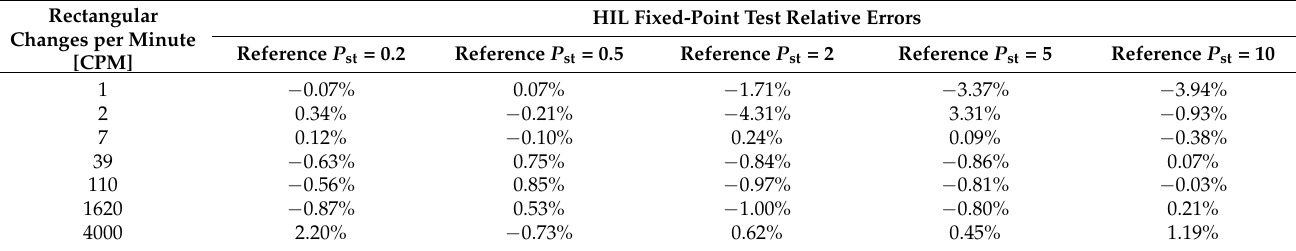
Table 9. Response to rectangular voltage fluctuations—HIL fixed-point tests.